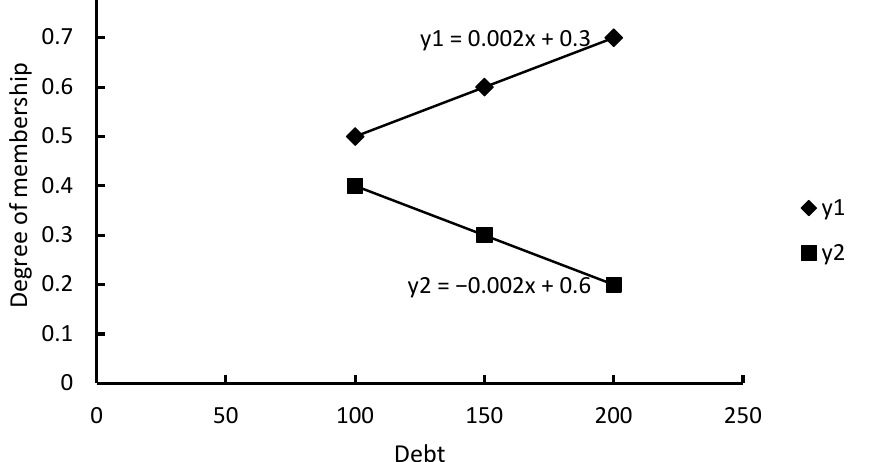
Figure A16. Single factor evaluation for the index of debt (100–200 (inclusive) ten thousand yuan).